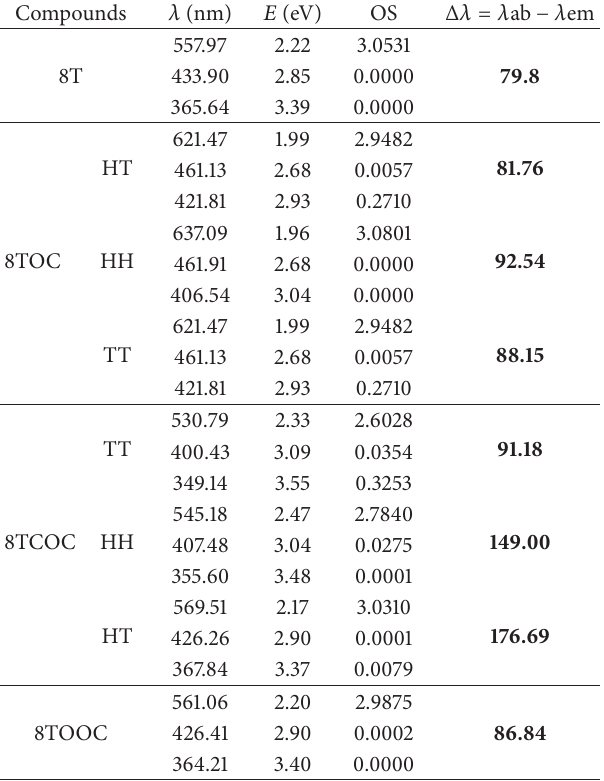
Table 5: Emission spectra in gaseous phase obtained by the TD- CAM-B3LYP/6-31G(d) optimized geometries of 𝑆 1 excited states for the